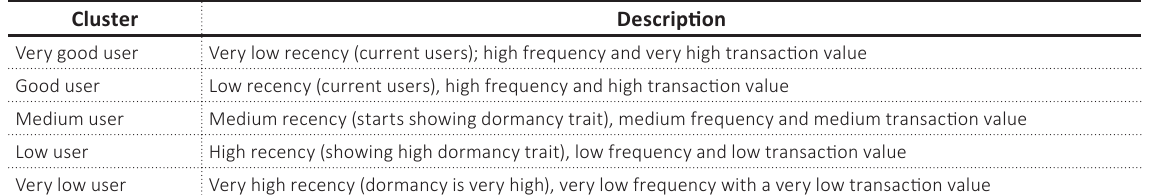
Table 3. Clusters definition and characteristics obtained from the combined algorithm